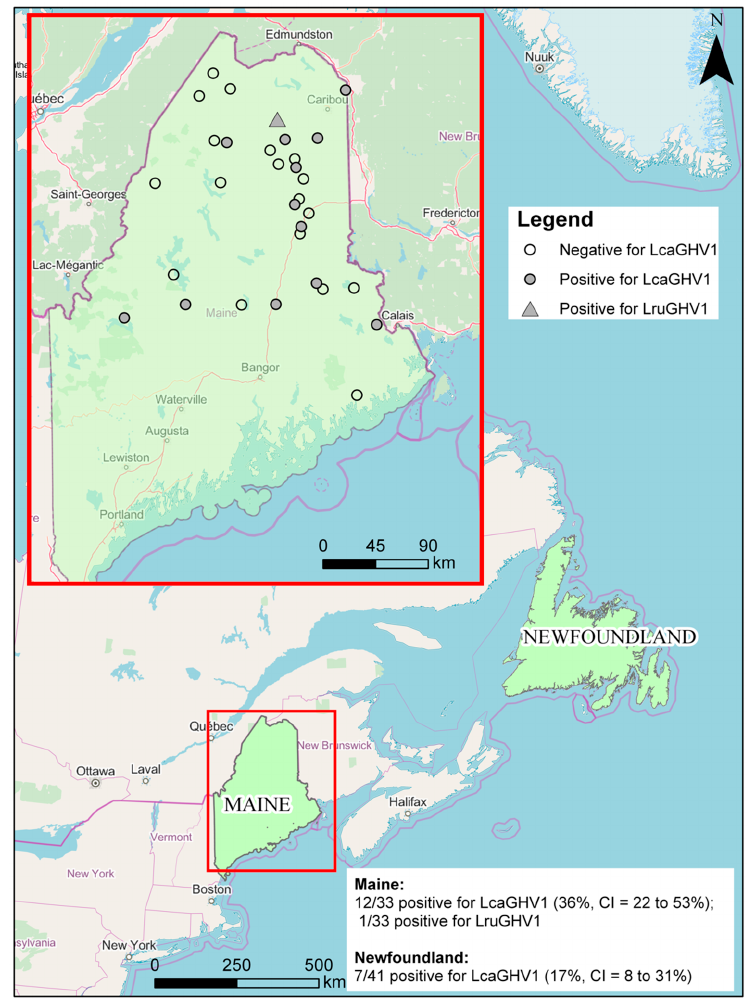
Figure 3. Geographic distribution of lynx samples. Both study sites are highlighted in green. For Maine the individual locations are shown for each lynx sample.